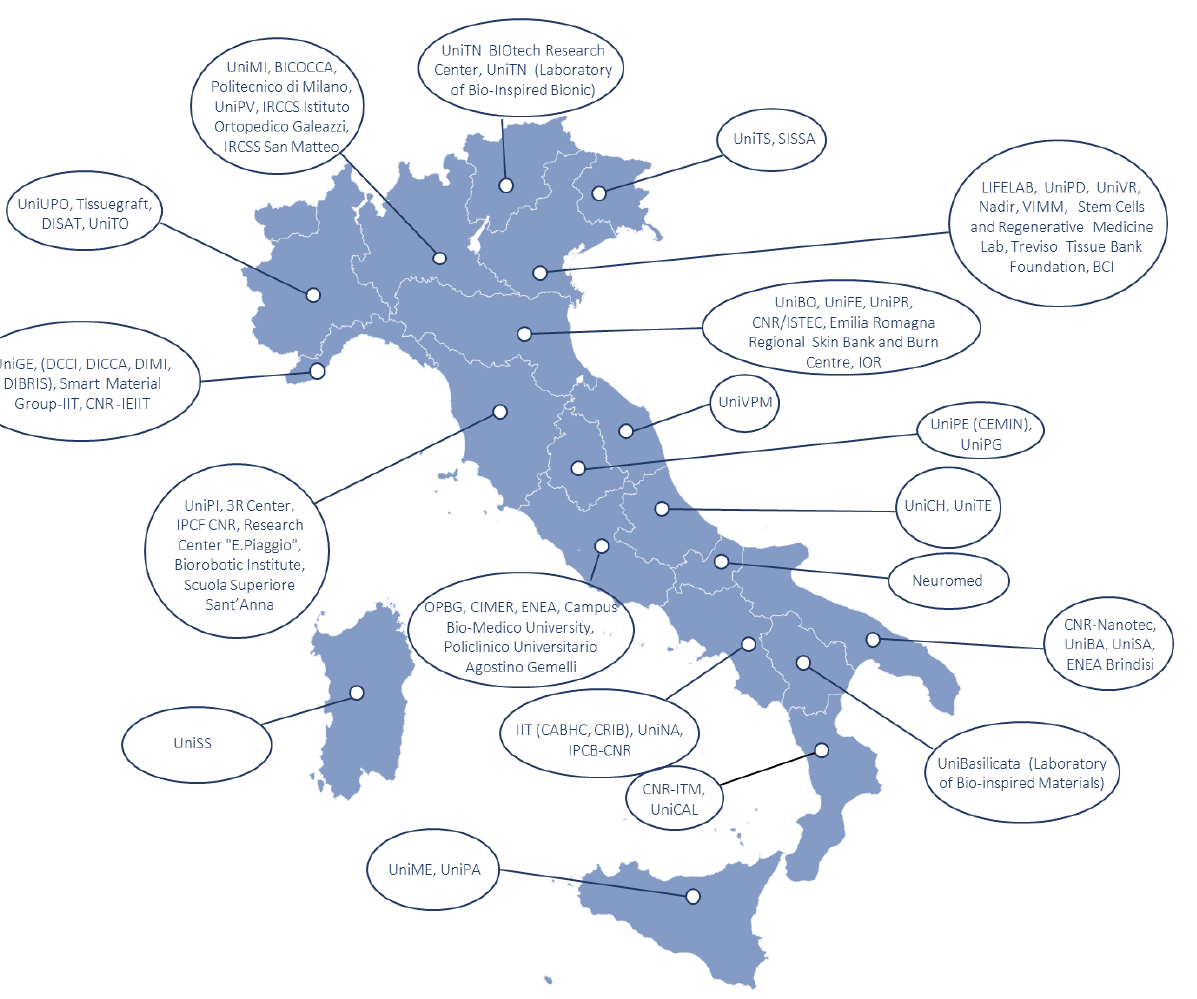
Figure 7. Distribution of the main research Italian centers for biomaterial production and testing.